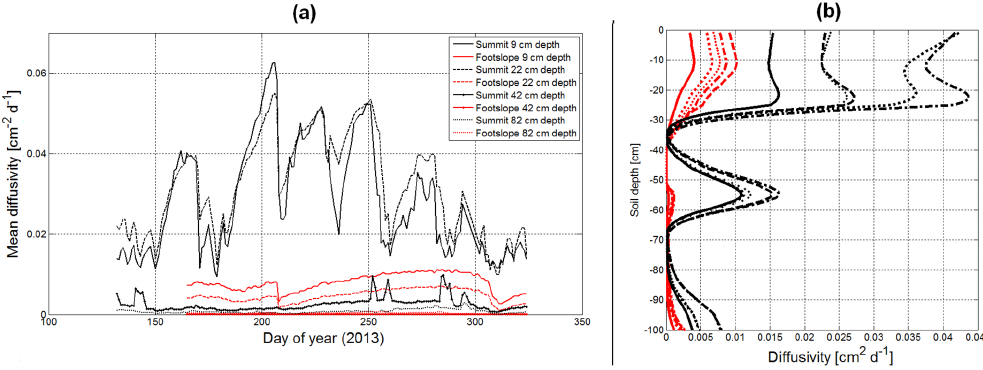
Figure 8. Space-time dynamic of soil CO 2 diffusivity at the summit (red) and the footslope (black) position in 2013: (a) time series at different depths; (b) profile at different dates. The legend of the curves in relation to the different depths and dates is given in Fig. 7.